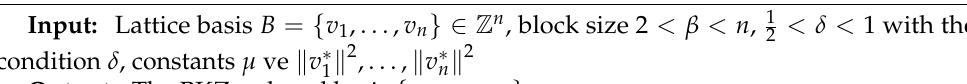
Algorithm 4 BKZ Algorithm